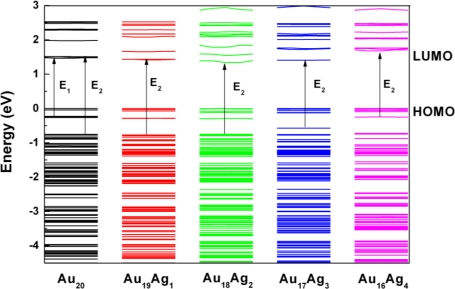
The outline of optical transition of Au20−nAgn clusters calculated by energy level.